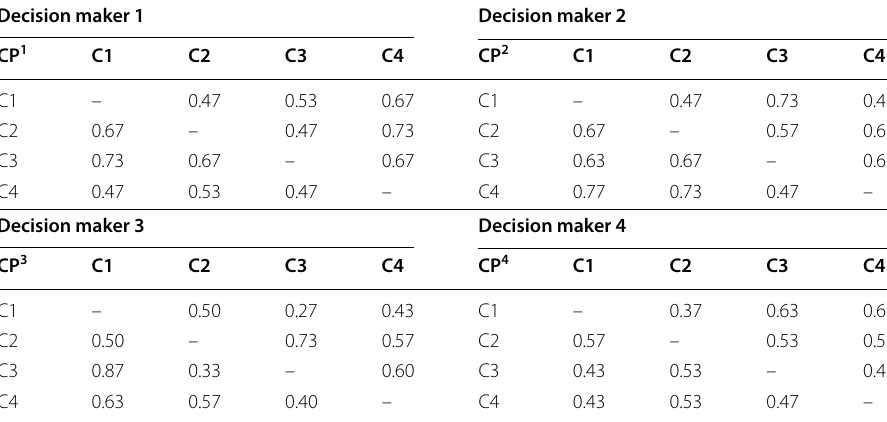
Table 6 Corresponding fuzzy preference relations for revenue sharing